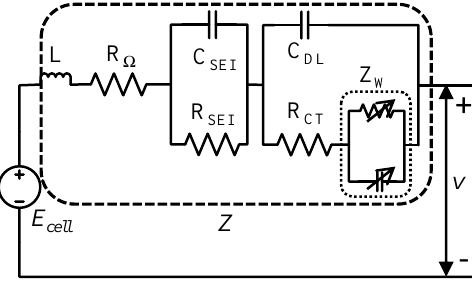
Figure 5. AR-ECM for a Li-ion